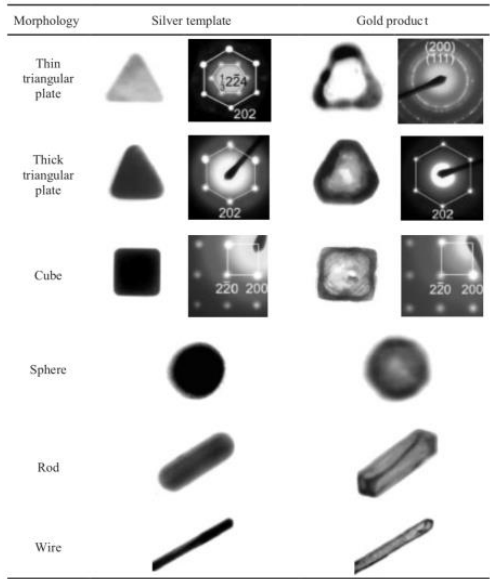
Figure 14. Silver nanoparticle morphology based gold shell synthesis. Reprinted with permission from Reference [72]. Copyright (2003) John Wiley and Sons.